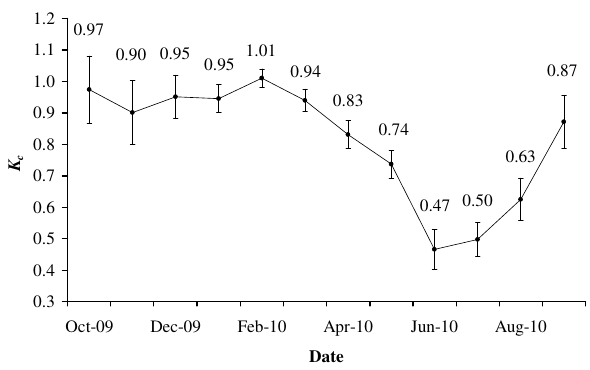
Fig. 8. The short grass reference evaporation (ET r ) from Octo- ber 2009 to September 2010 in the Mfabeni Mire.